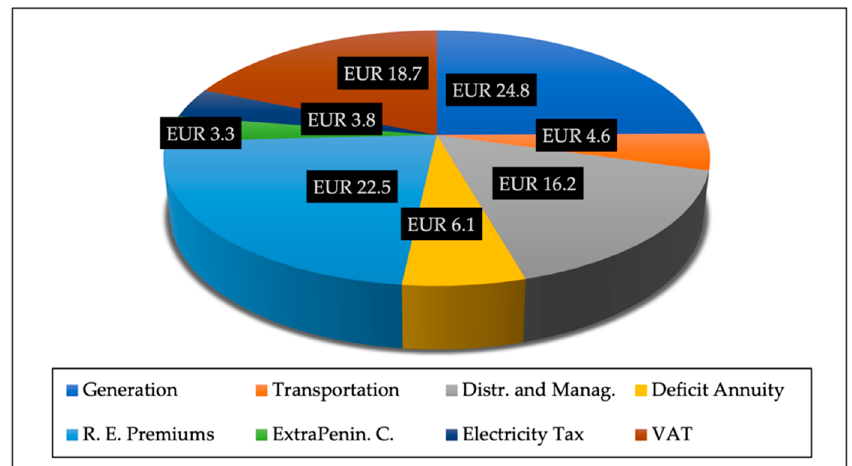
Figure 5. Spain’s electricity bill for industrial users as of the middle of 2021 (per EUR 100). Source: Own elaboration from CNMC [95].